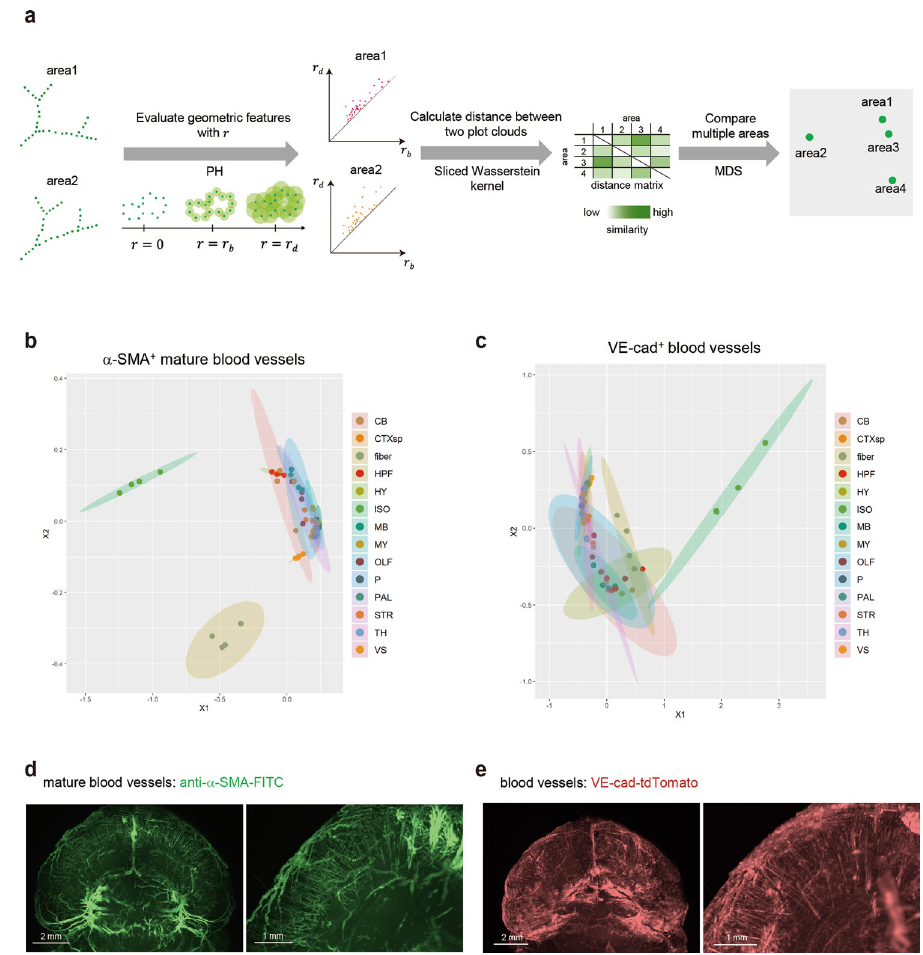
Fig. 5 | Analysis of brain blood vessels using TDA. a To extract the geometric features, persistent homology (PH), a main method of topological data analysis (TDA), is used. This method can evaluate structures by making virtual circles from the classi fi ed signals as a starting point. When the size of concentric circles is increased little by little, the larger circle will appear which connects them (birth time of circle). When the size of concentric circles become even larger, the appeared circles will disappear (dead time of circle). The radius of concentric cir- clesatthebirthtimeisde fi nedas r = r b ,andtheradiusatthedeadtimeisde fi nedas r = r d . These values ( r b and r d ) are plotted as persistent diagram. To compare two areas based on their features, the distance between the two point clouds shown in PD is calculated by the Sliced Wasserstein kernel. Using the distance matrix obtainedby calculating the distancesbetween the point clouds in all pairsofareas by the Sliced Wasserstein kernel as an input, the proximity between areas from a